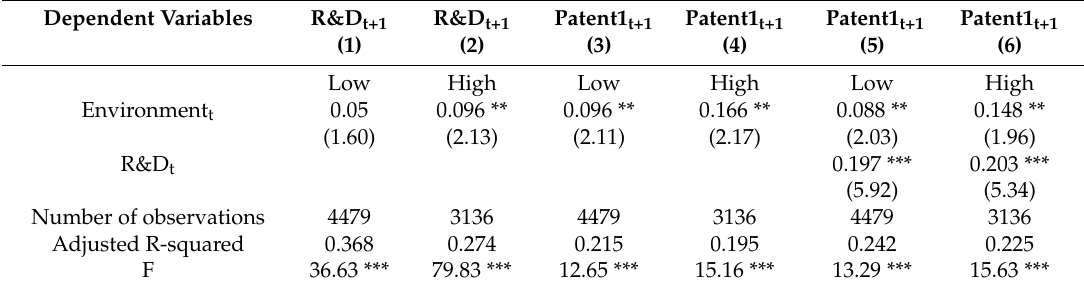
Table 7. The moderating effect of